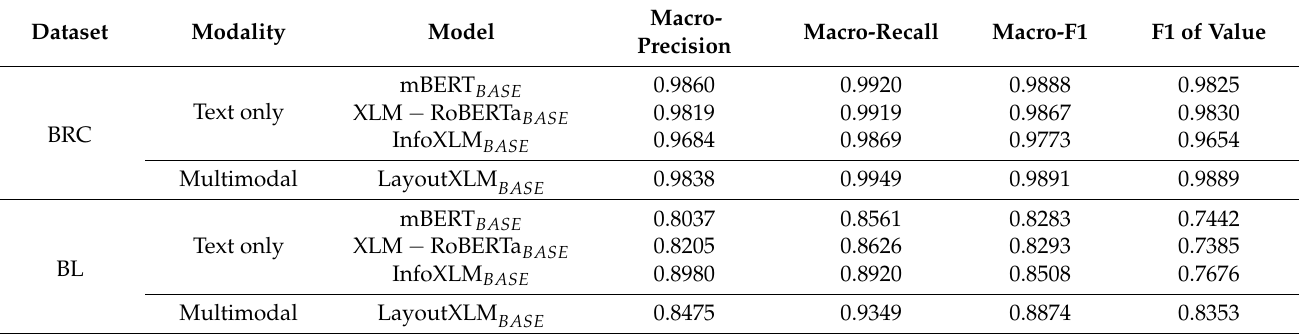
Table 2. Performance of key information extraction with key-value